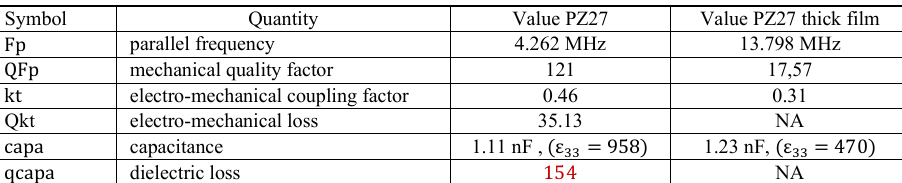
Electro-mechanical parameters of PZ27 and PZ46 samples fitted with model.